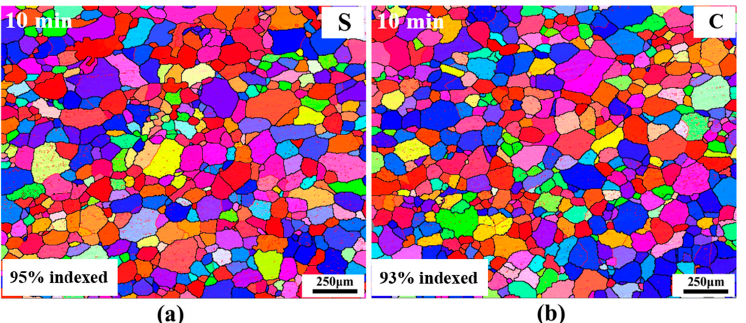
Figure 9. The ODF sections ( φ 2 = 45°) of 70% clock-rolled Ta plates in the surface and center layers when annealed at 1050 °C for 120 min: ( a ) Surface layer, ( b ) center layer.